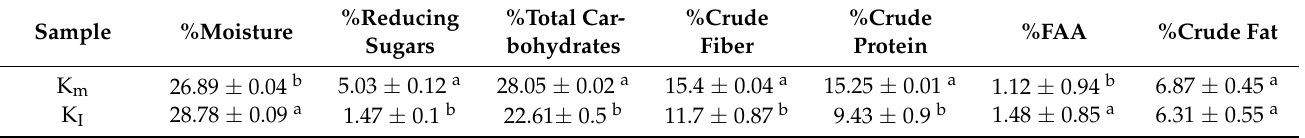
Table 2. Moisture, reducing sugars, total carbohydrate, fibers, crude protein, total free amino acids (FAA) and crude fat content (dry weight bases) of mature (K m ) and immature (K I ) fruits of K. pinnata.